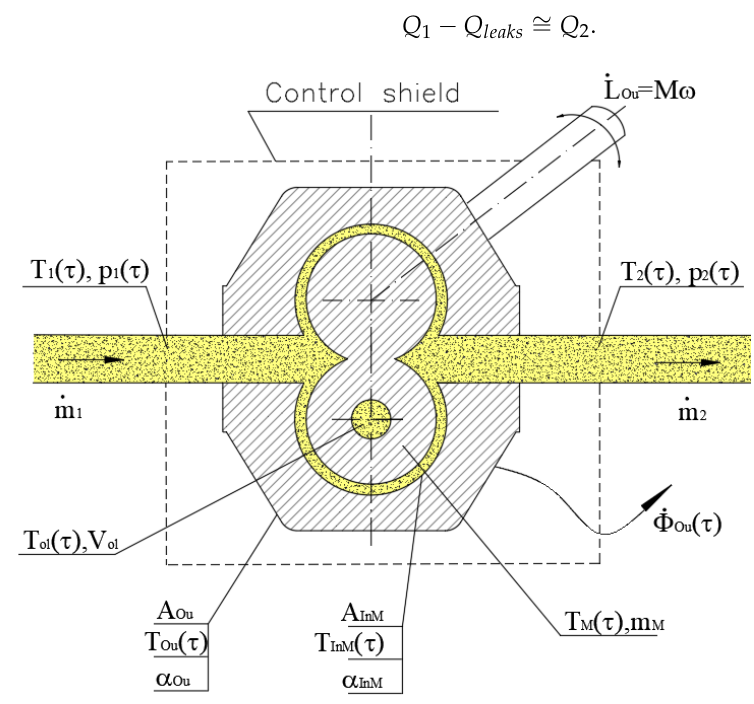
Figure 3. Parameters for determining the energy balance in a hydraulic motor ( A —surface, T —tem-